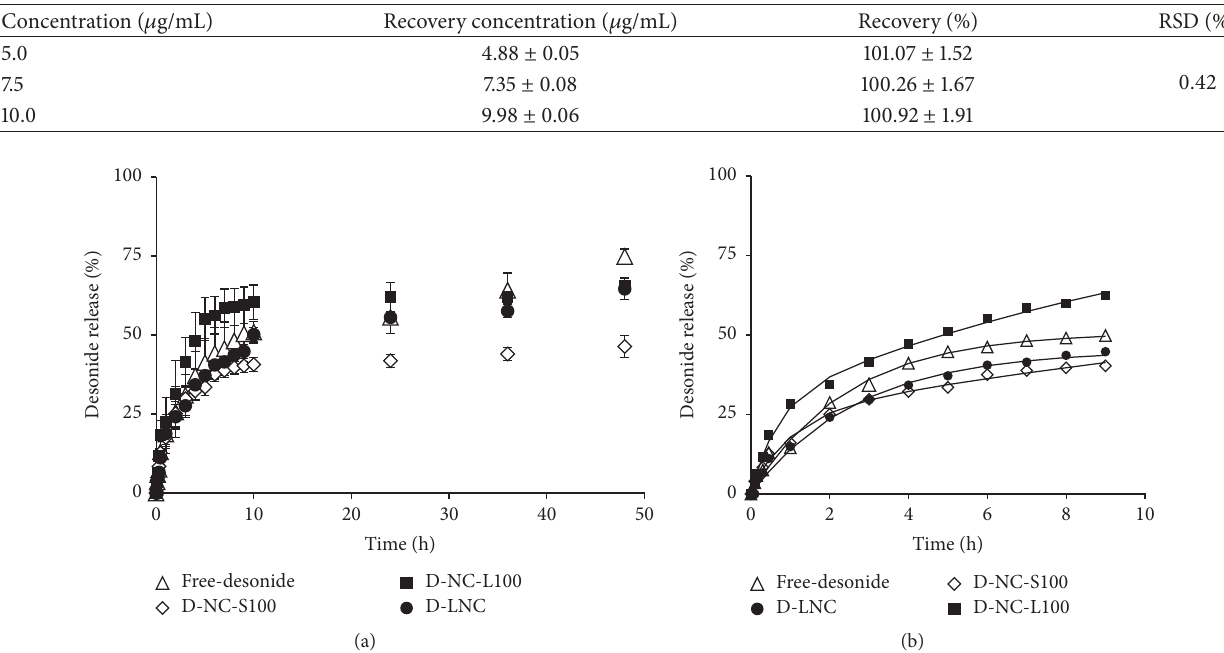
Table 3: Experimental values of the accuracy of the method.